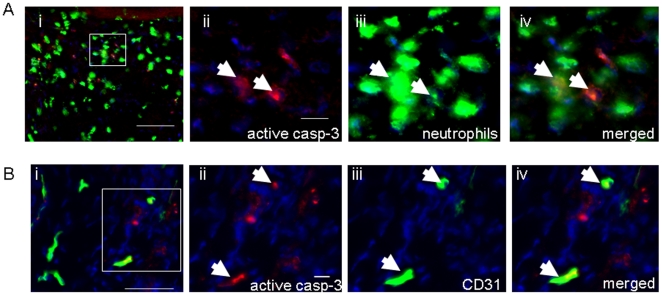
Identification of apoptotic neutrophils and endothelial cells in diabetic wounds.Representative immunostained section of: A, day 3 wound showing neutrophils (green) and active casp-3 (red) staining; and B, day 7 wound showing endothelial cells (CD31, green) and active casp-3 (red) staining. Nuclear counterstaining was performed using DAPI (blue). i, Low power (20x) images, Scale bar  = 50 µm.; ii-iv, high powered images of the boxed area in i showing active casp-3 (red) and DAPI (blue) (ii) anti-neutrophil or anti-CD31 (green) and DAPI (blue) (iii); and merged images of anti-neutrophil/anti-CD31 and active casp-3. Casp3 positive neutrophils/endothelial cells are shown with white arrows. Scale bar (Aii-iv and Bii-iv)  = 10 µm.